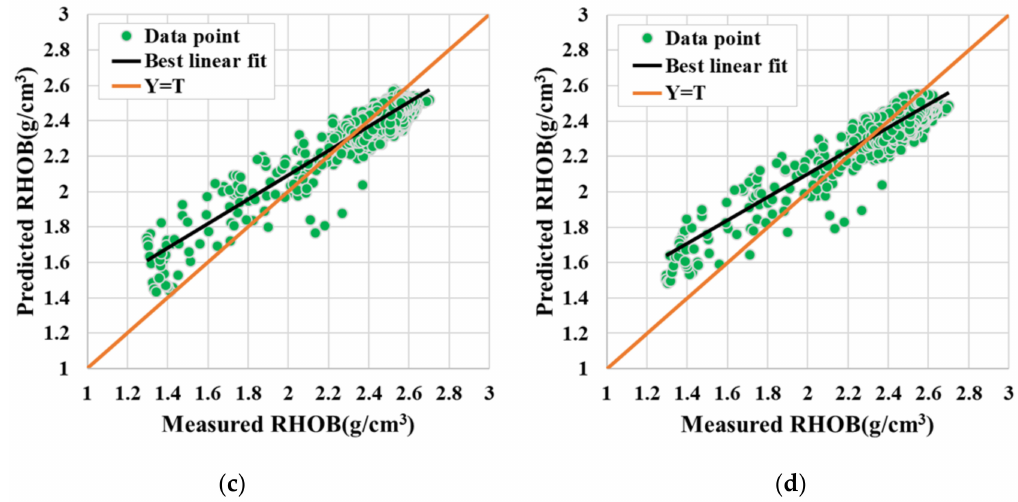
Figure 8. ( a ) BO-HKELM, ( b ) HKELM, ( c ) KELM, ( d ) ELM. The cross plot of measured RHOB versus